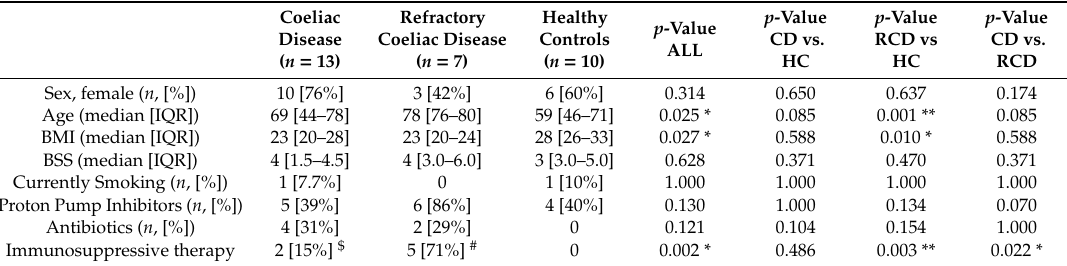
Table 1. Baseline